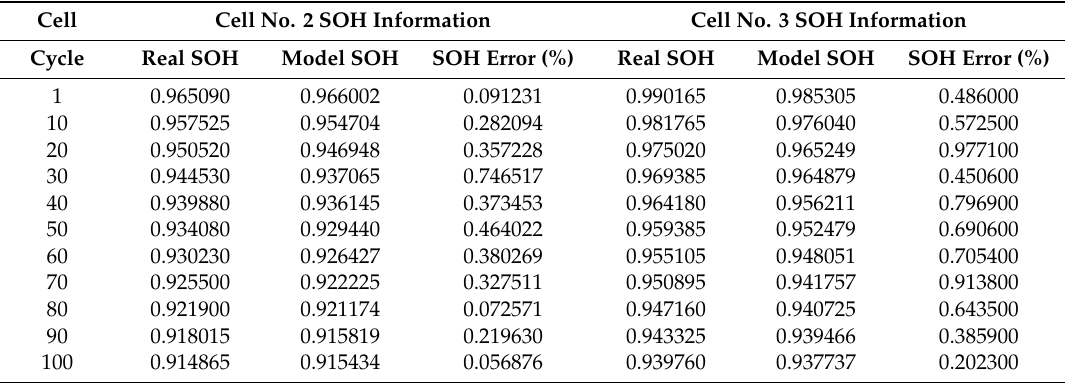
Figure 17. Comparison between the linear regression model based on the partial capacity of cell no. 1 and a real SOH based on two partial capacities of cell nos. 2 and 3. Table 1. Numerical results for the comparison between the linear regression model based on the IC curve peak point of cell no. 1 and a real SOH based on two IC curve peak points of cell nos. 2 and 3 cells (SOH error = Real SOH − Model SOH).